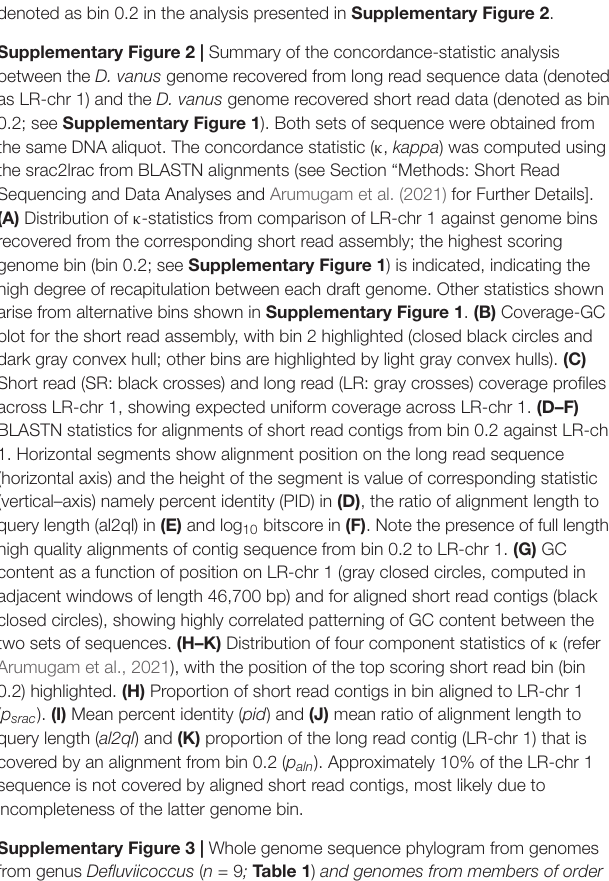
Supplementary Figure 3 | Whole genome sequence phylogram from genomes from genus Defluviicoccus ( n = 9 ; Table 1 ) and genomes from members of order Rhodospirillales ( n = 85) available in the GTDB database. Whole genome distance statistics were computed within GTDB-Tk. Following Onetto et al. (2019), genomes from members of the genus Gemmatimonas ( n = 5) were assigned as the outgroup taxa. See Section “Materials and Methods: Comparative Analyses of Defluviicoccus genomes” for